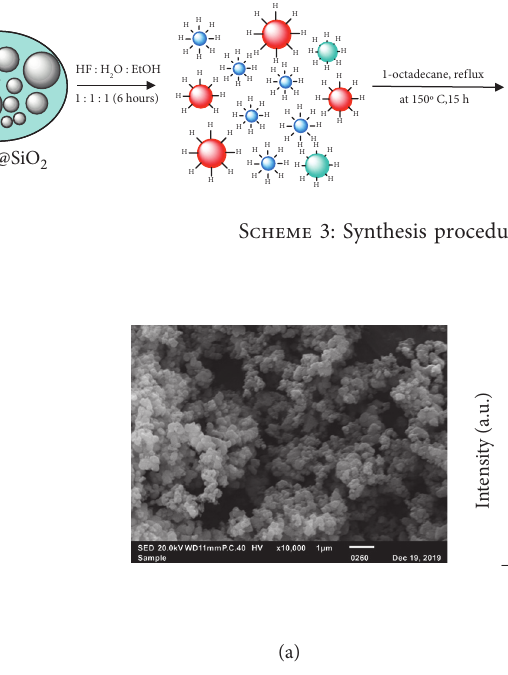
Figure 1: Scanning electron microscopy (SEM) image of SiO 2 NPs (a) and powder X-ray diffraction pattern of SiO 2 NPs (b).